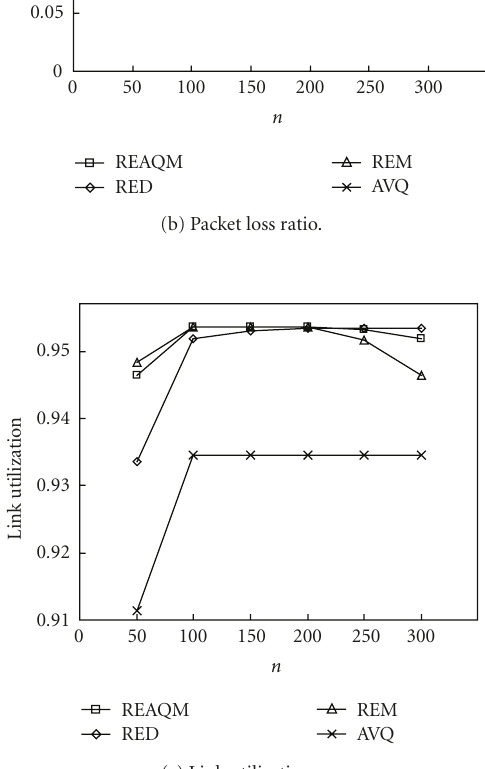
Figure 3: Performance test versus number of FTP flows for the dif- ferent AQM schemes over wired